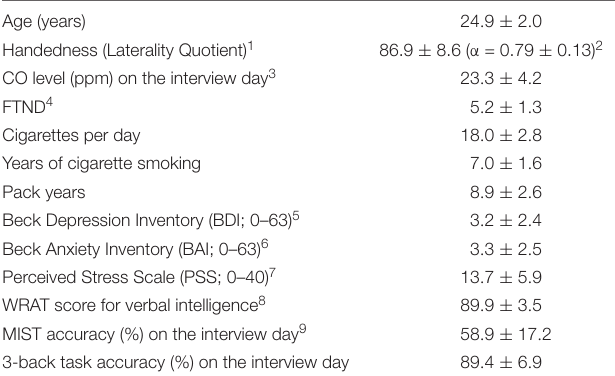
TABLE 1 | Demographics and behavioral data for the participants ( n = 18) obtained on the interview day. Age